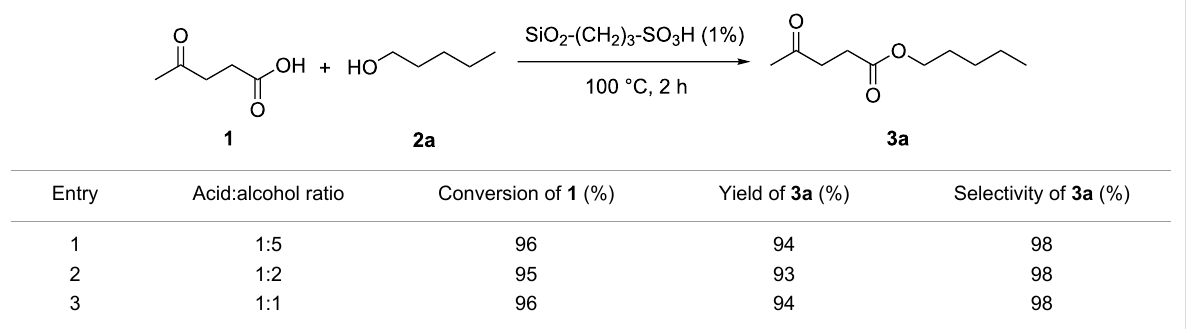
Table 2: Variation of the acid/alcohol